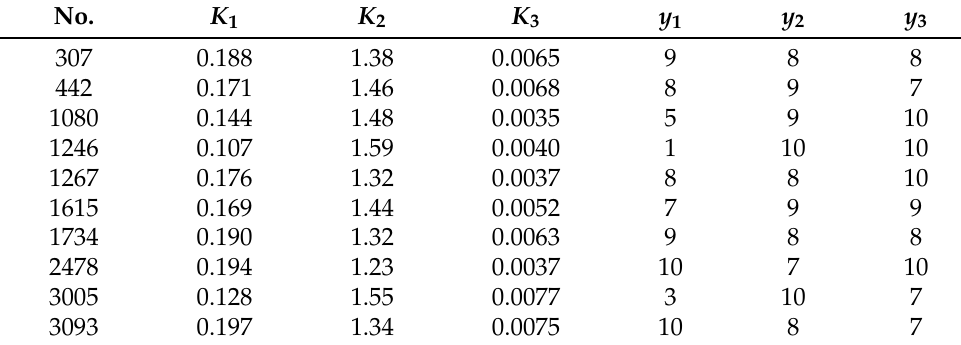
Table 3. 10 vector scores and their the corresponding alternatives.